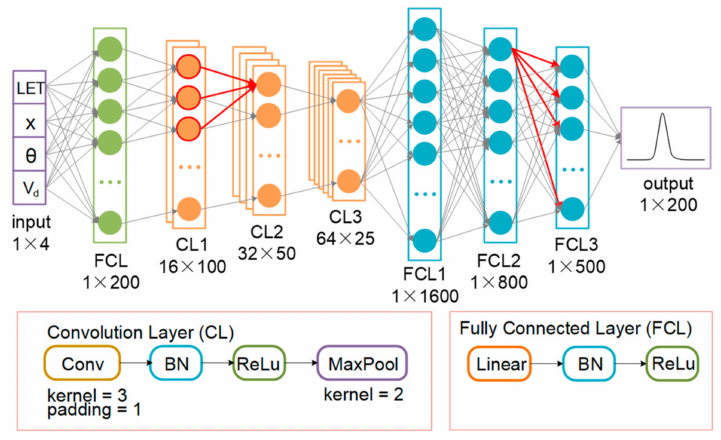
Figure 4. The network structure for predicting drain transient current pulses.